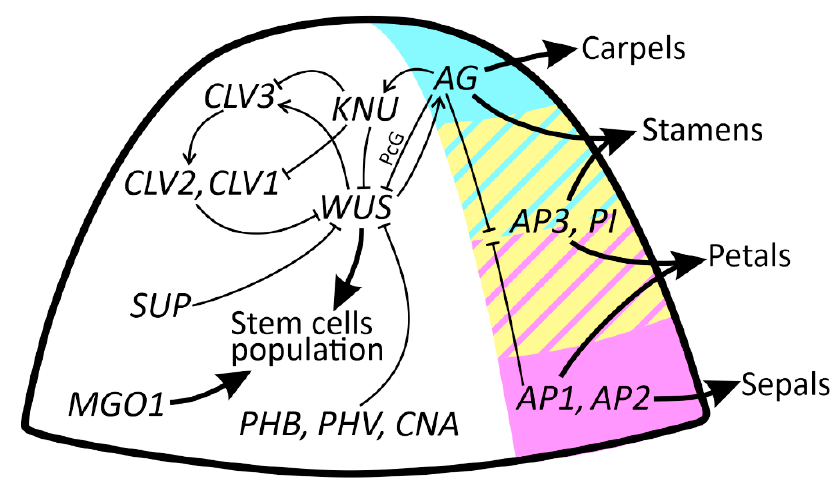
Figure 2. Regulatory network patterning the floral meristem and potentially affecting carpel number. Key: purple color = area of expression of A-class genes; yellow color = area of expression of B-class genes; blue color = area where C-class gene expresses; pointed arrows = positive regulation; blunt arrows = negative regulation; thicker arrows = phenotypic effect. Except for ABC genes, other genes are represented schematically without reflecting the actual sites of their expression. Gene abbreviations and detailed information on the pathways are explained in the text.